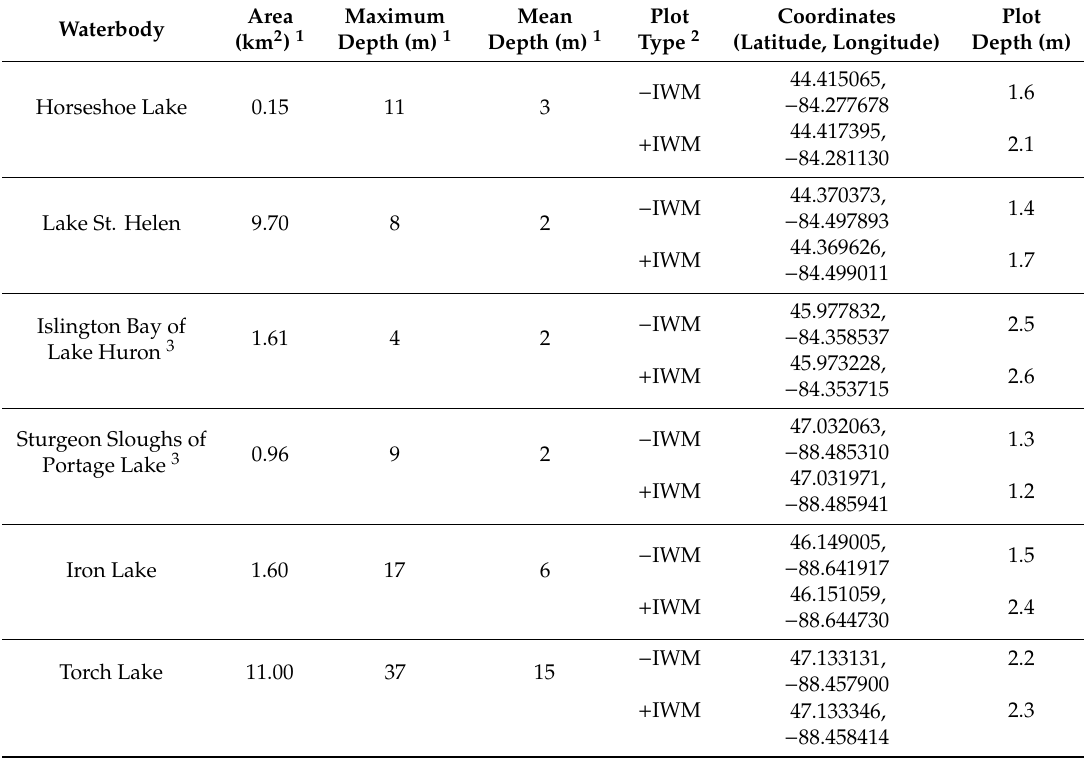
Figure 2. Locations of waterbodies used in this study (black dots) across Michigan, USA. Coordinates of outside frame are in decimal degrees (WGS 84). Table 1. Locations and physical descriptions of waterbodies and study plots.